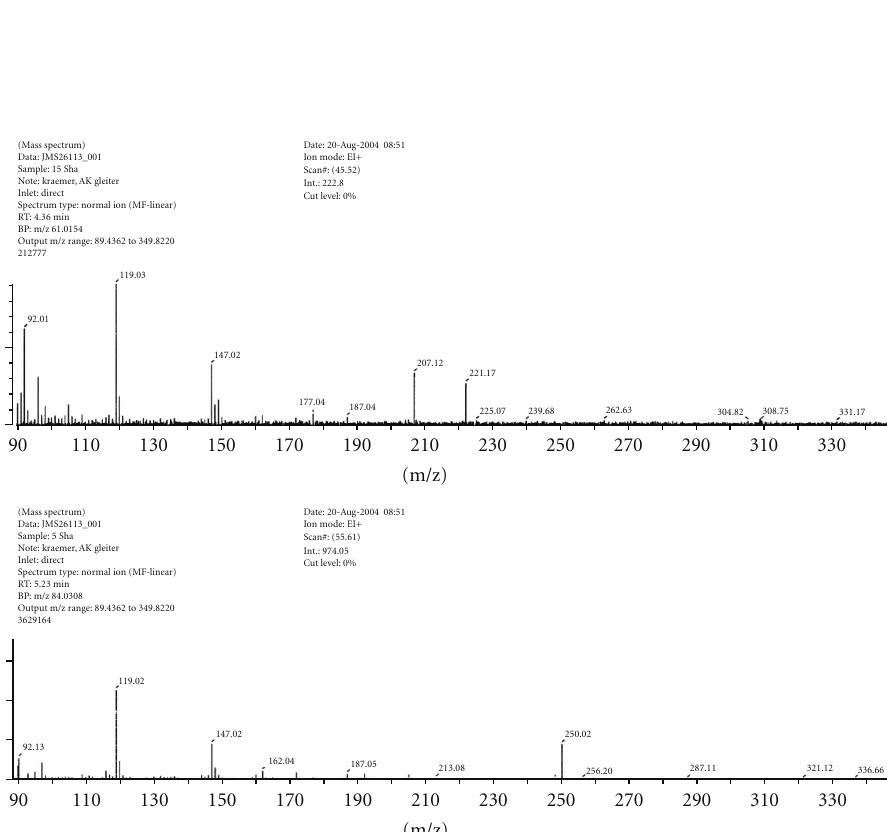
Figure 5: Mass spectrum of L II H.